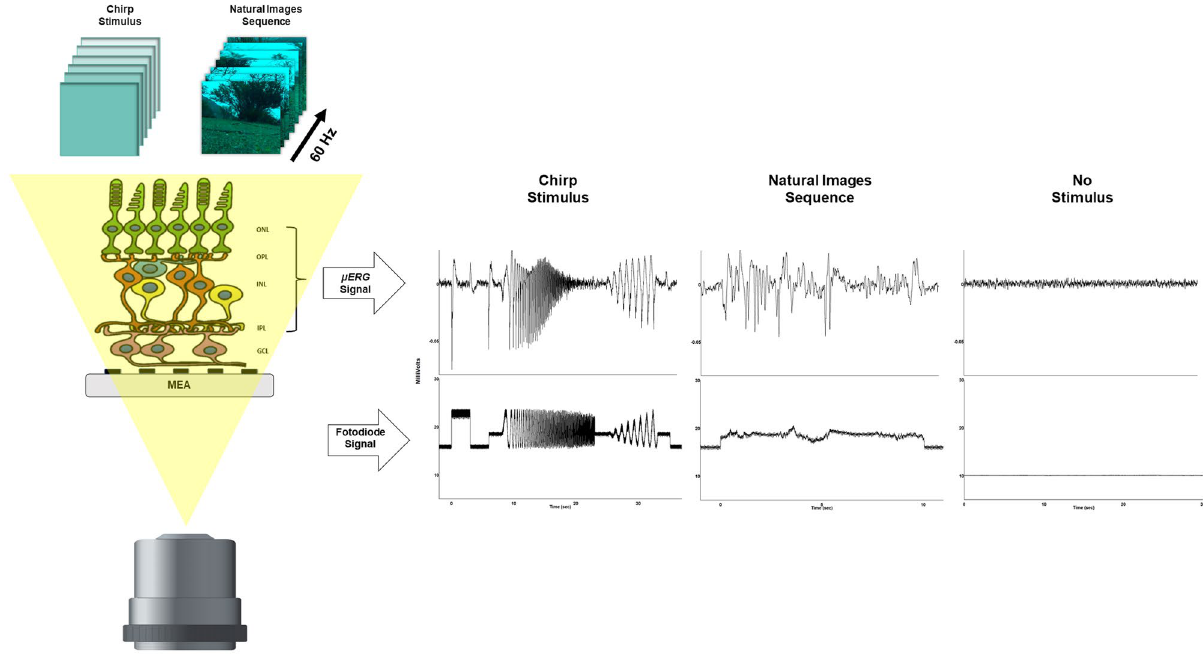
Figure 1. Multielectrode array (MEA) recordings of retinal responses to visual stimuli. A MEA was mounted on a piece of retina to record µ ERG signals of the electrophysiological activity of several cell types of the retinal network, including those in the outer nuclear layer (ONL), outer plexiform layer (OPL), inner nuclear layer (INL) and inner plexiform layer (IPL). The firing activity of retinal ganglion cells (GCL) was low-pass filtered of the µ ERG. Two types of visual stimuli were applied using a LED projector: (1) A so-called chirp stimulus (CS protocol), and (2) A sequence of natural images (NI protocol). Examples of peristimulis time histogram (PSTH) from the µ ERG recordings, in response to 21 repetitions of the CS and the NI protocols (on the right side), together with a fotodiode signal recorded simultaneously to keep track of the stimulus intensity. For reference, it is also shown a µ ERG recording during a period of no visual stimulation.